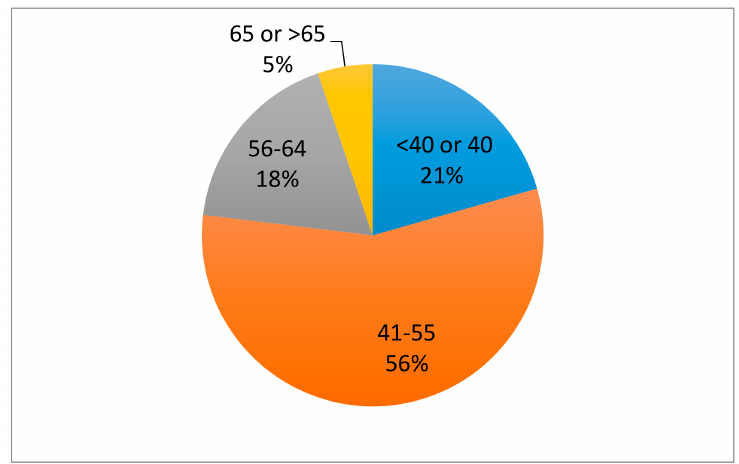
Figure 6. Age of